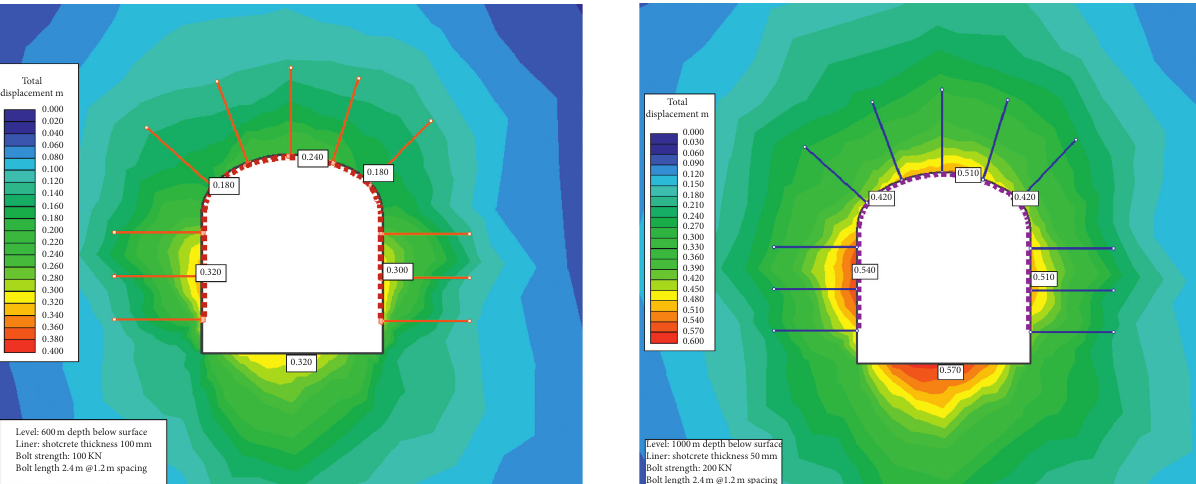
Figure 8: Displacement of scheme